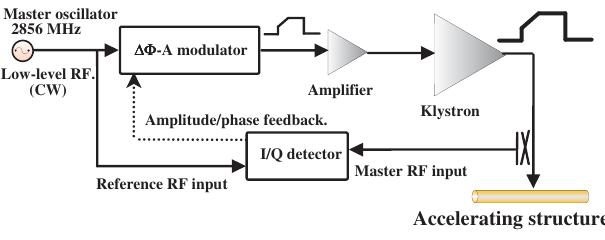
FIG. 1. (Color) Overview of the initial-beam-loading compen- sation system.